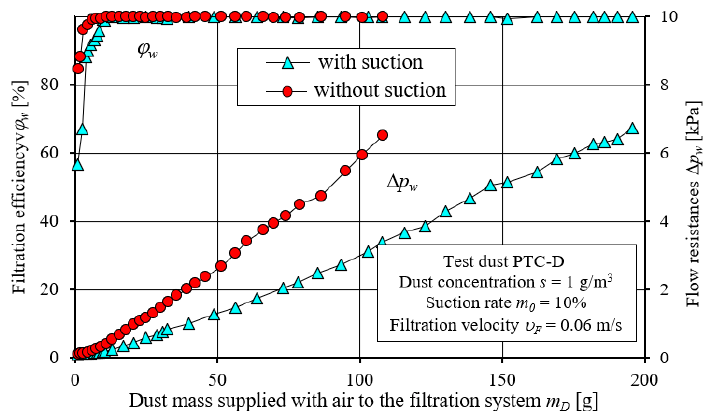
Figure 7. The change in the flow resistances Δ p w = f ( m D ) and filtration efficiency φ w = f ( m D ) of the paper filter cartridge operating while positioned in series behind the pass-through cyclone with the ejective dust removal and without any dust removal.